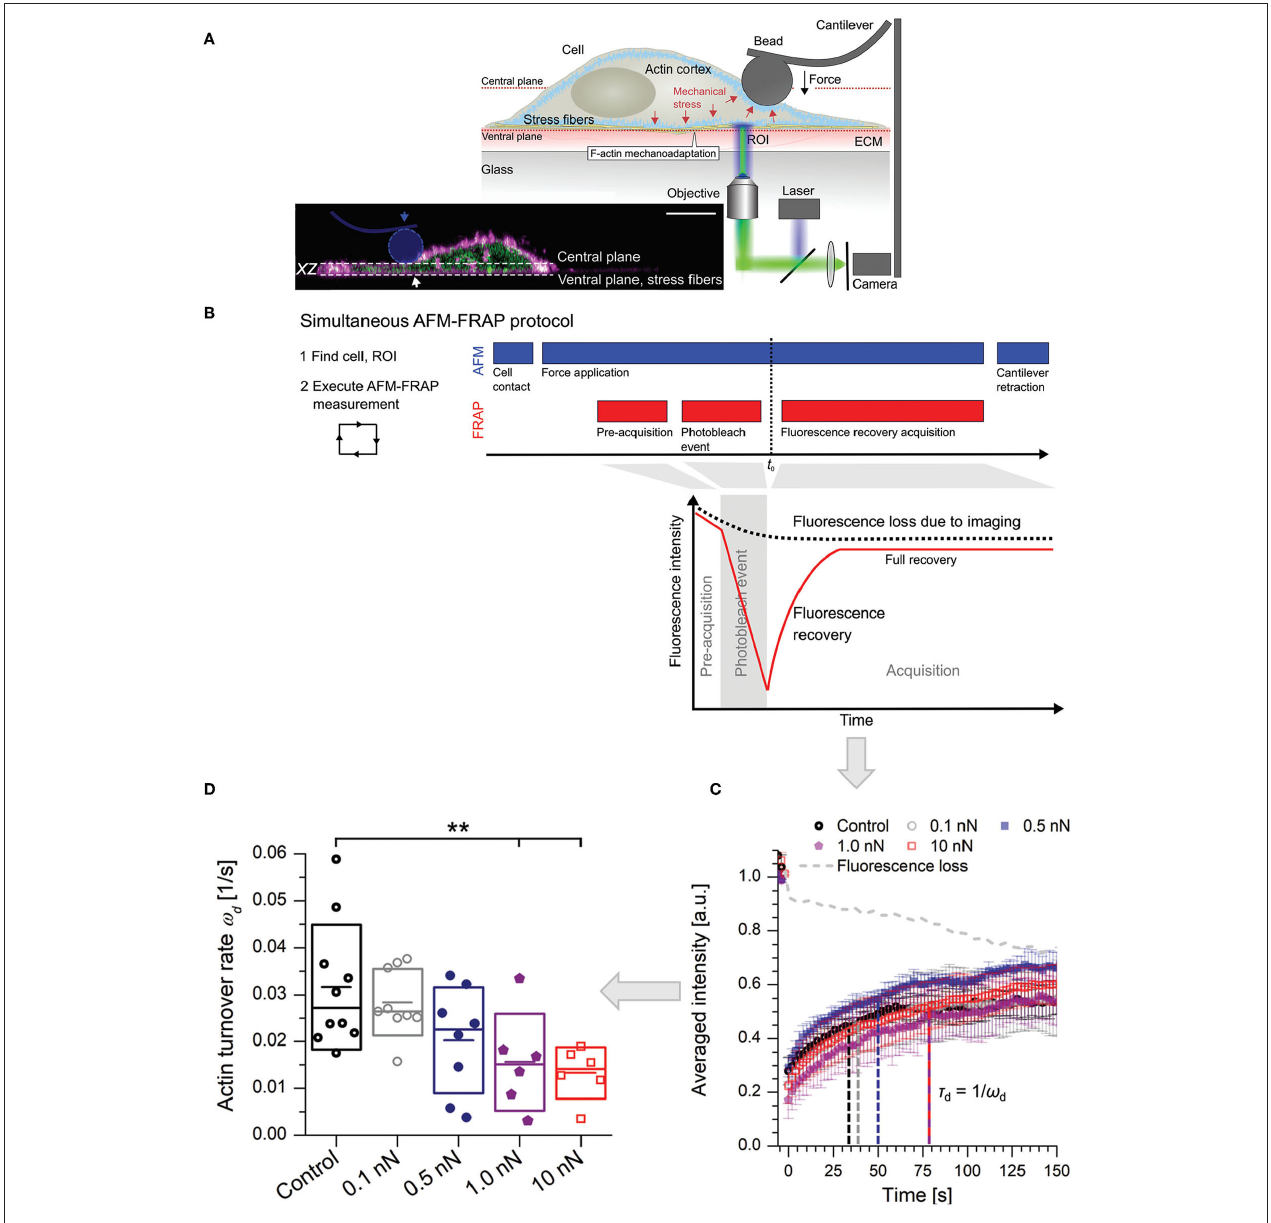
FIGURE 6 | Combined AFM-FRAP for the detection of a physiological response in the immediacy of the basal membrane of cells subjected to apical stress. (A) The experimental set-up. The inset features a real-life cross-section of an adherent cell. (horizontal scale bar = 10 µ m, distance between planes = 4 µ m). (B) Experimental protocol. Force is kept constant and applied at least two minutes before acquisition of fluorescence recovery data. (C) Typical fluorescence recovery curves as a function of applied force. The turnover rate is indicated in relation with the characteristic recovery time. (D) Statistical results of turnover rates (**, level of significance p < 0.01). (Figures reproduced from Skamrahl et al., 2019 with permission 2